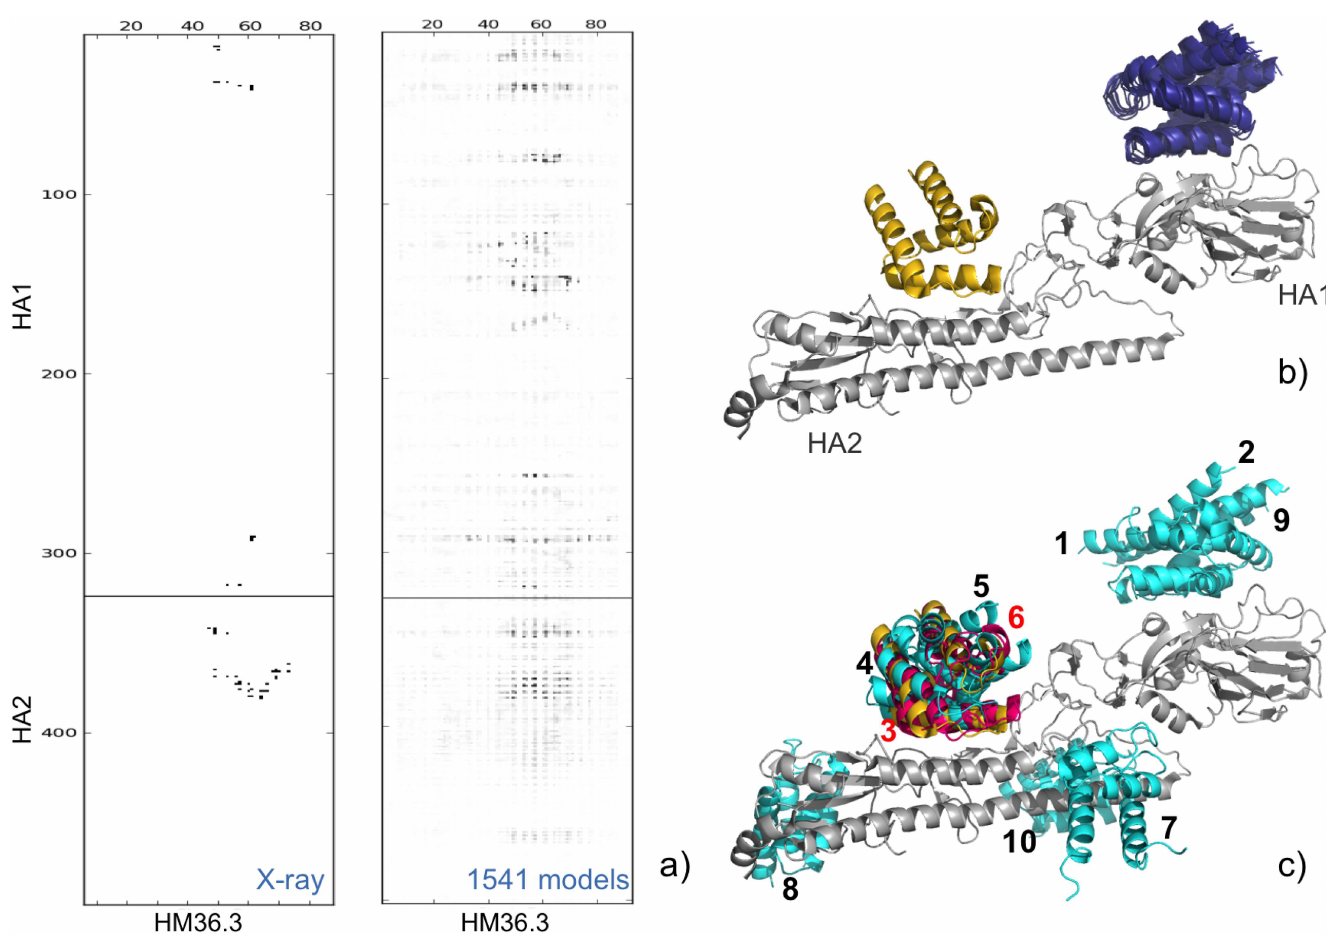
Fig 2. T50 scoring. ( a) X-ray structure contact map obtainedby COCOMAPS [28] (left) and consensusmap from the 1451 available models (right). ( b, c) 3D representation of the T50 target experimental structure and of selectedmodels by CONSRANK (b) and by Clust-CONSRANK—MC /10 (c). X-ray receptorand ligandare colored silver and gold, respectively.Ligandsof models selectedby CONSRANK are colored deep blue, whileincorrect and correct solutionsselectedby MC /10 are colored light blue and hot pink, respectively.